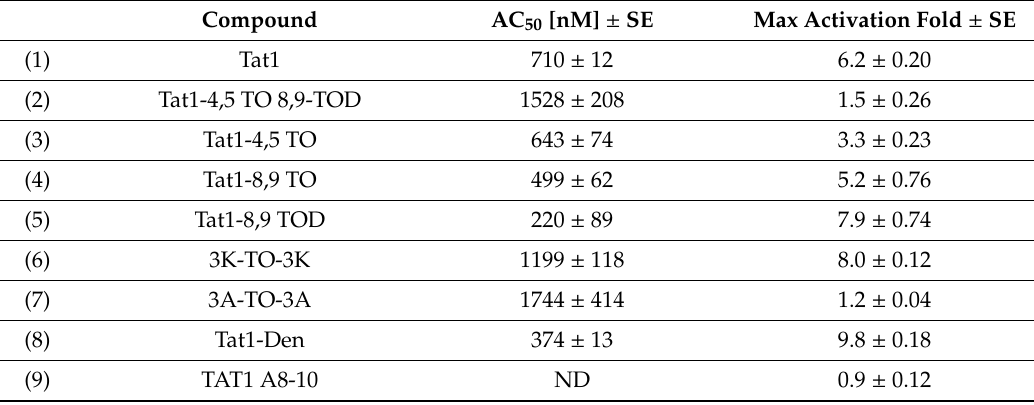
Table 2. Peptides based on HIV-1 Tat protein fragment, Tat1, are potent activators of the 20S